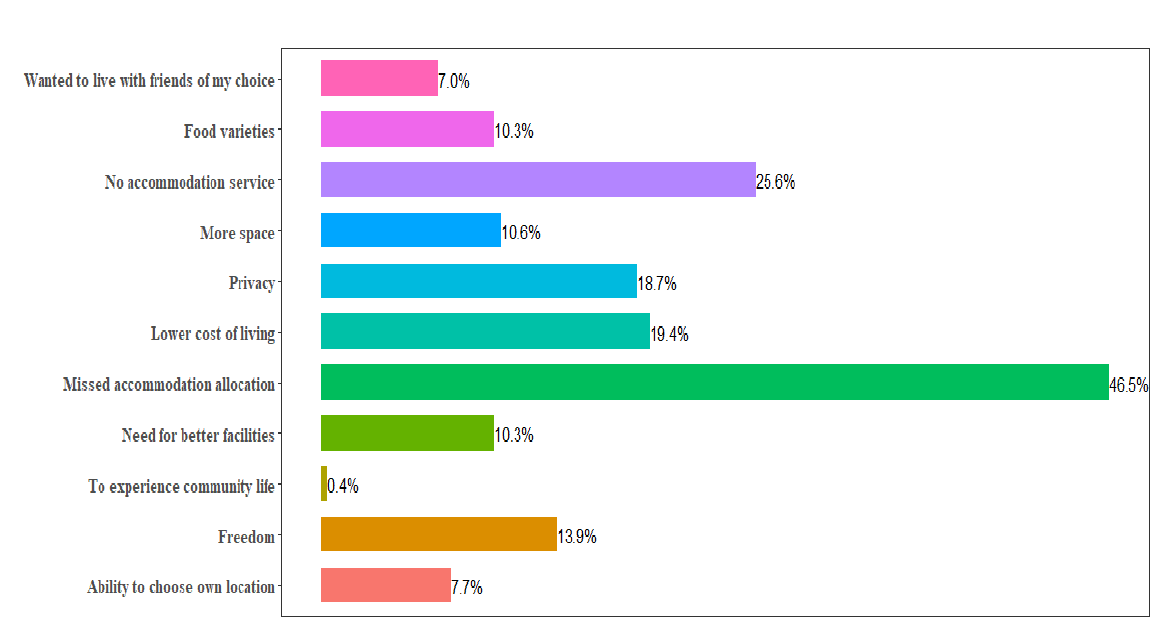
Figure 4. Reasons for Renting Accommodation from Private